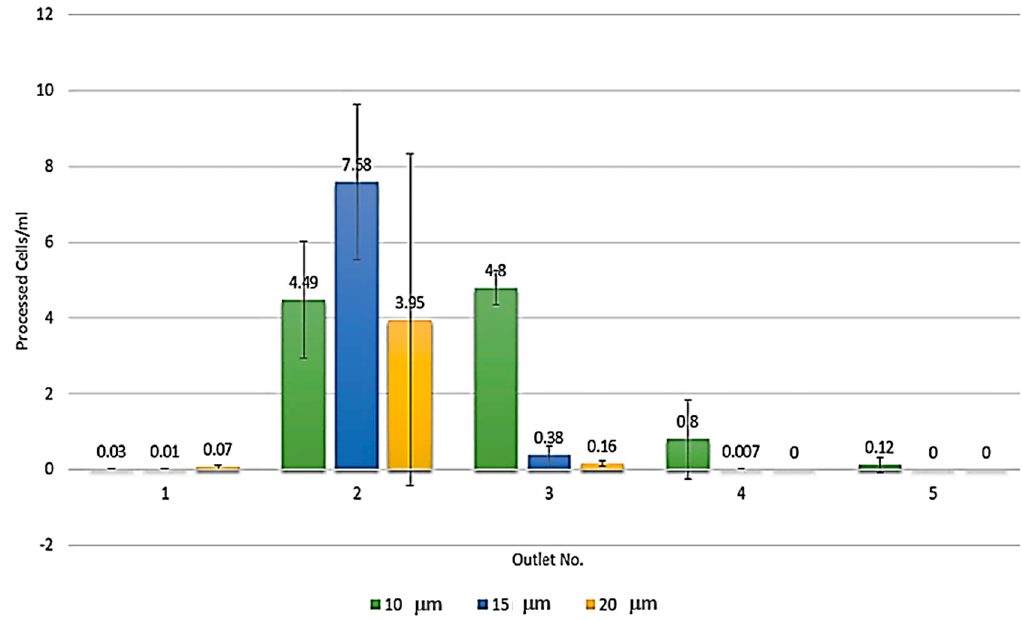
Figure 1. The histogram plotted from the preliminary data illustrates the tendency of mast cell tumor (MCT) cell focusing and distribution in our predesigned spiral microchannel. Most of the larger cells sized from 10 µ m were focused and distributed through the outlets II and III of the microdevice. In contrast to small MCT cells, they were unfocused and dispersed through the outlets I to V. Notably, the sizes of individual MCT cells from each outlet were measured by fluorescence-activated cell sorting (FACS) size-based quantification [21].